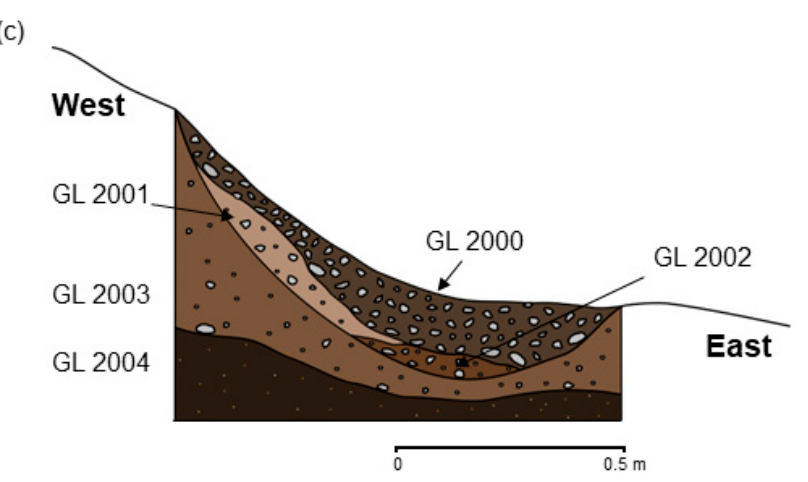
Figure 3. Stratigraphic data: ( a ) Tri Stene Rockshelter during luminescence sampling, analysis underway; ( b ) Schematic drawing of the lithological units and location of key archaeological materials identified at Tri Stene Rockshelter; ( c ) Schematic cross-section drawing from Geo-trench 1.